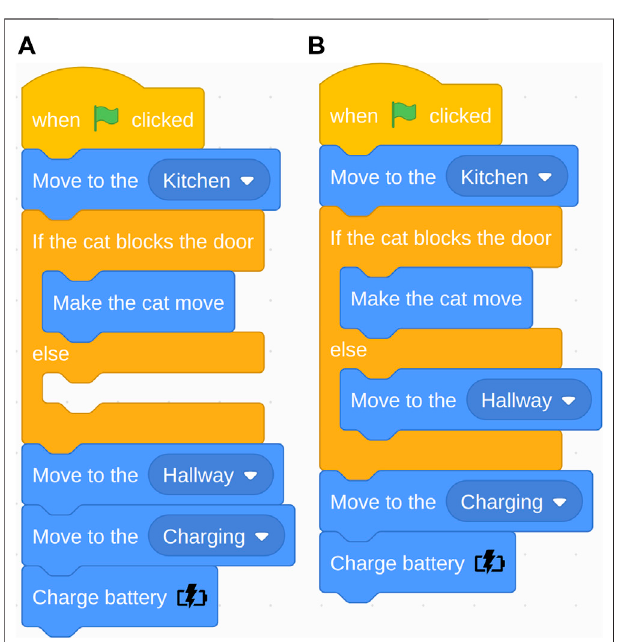
FIGURE7| Navigation task: Correct program (A) and the “ else ” in theif- else conditional incorrectly used as “ then ” (B)